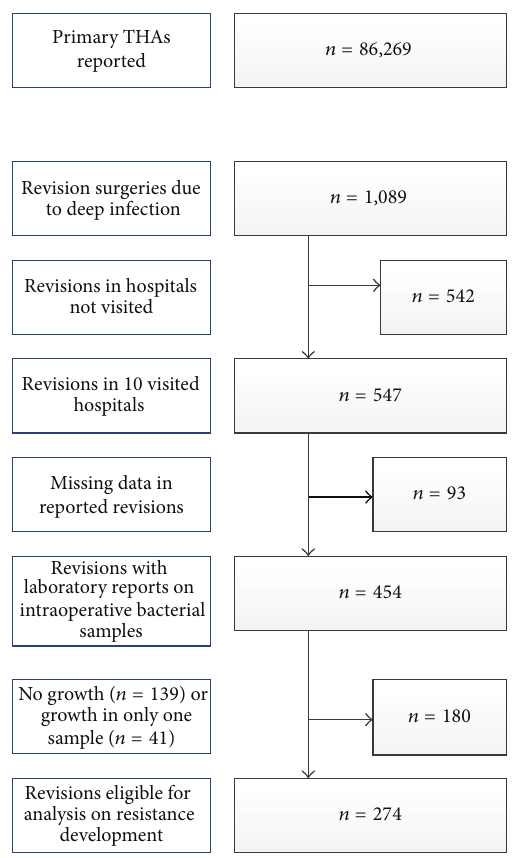
Figure 1: Flowchart showing the selection of patients.